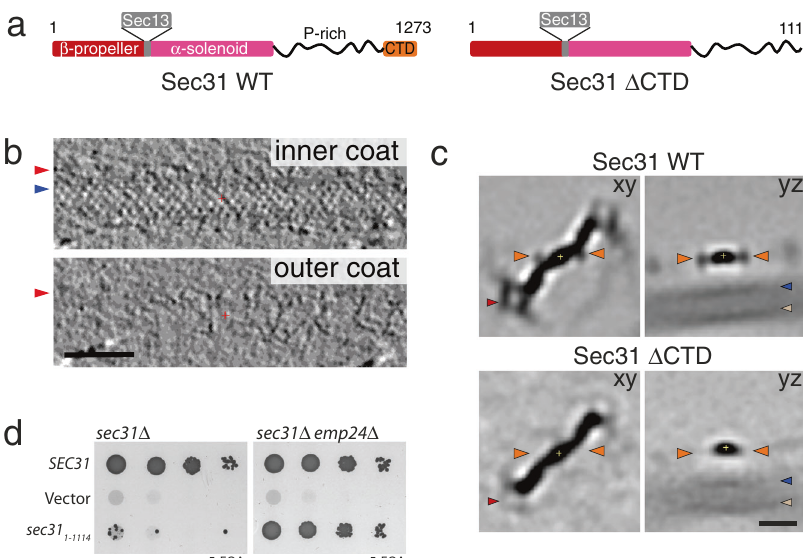
Fig. 3 Role of the Sec31 CTD. a Domain organisation of wild-type Sec31, and the Δ CTD mutant. b Slices through different z heights of a binned and fi ltered representative cryo-tomogram of COPII-coated tubule formed with Sec31- Δ CTD. Arrowheads as in Fig. 1a. The outer coat appears partially disordered. Scale bar 50 nm. These images are representative of tubes from 47 tomograms. c Top panels: slices through xy and yz planes of 8× binned subtomogram average of rods extracted from wild-type tubules. Orange arrowheads indicate the appendage density in Fig. 2d. Red arrowhead indicates the vertex, and beige is the membrane. Bottom panels. The same slices for the average of rods extracted from tubules formed with Sec31- Δ CTD. Extra density is absent, con fi rming its assignment to Sec31 CTD. The density for the vertex and membrane is also fainter, indicating overall disorder of rods in this sample. Scale bar 10 nm. d Left panel: a sec31 Δ yeast strain transformed with the indicated plasmids was tested on 5-FOA, revealing lethality associated with deletion of the CTD. Right panel: the same plasmids were transformed into a sec31 Δ emp24 Δ yeast strain revealing rescue of viability. A representative result is shown from at least three